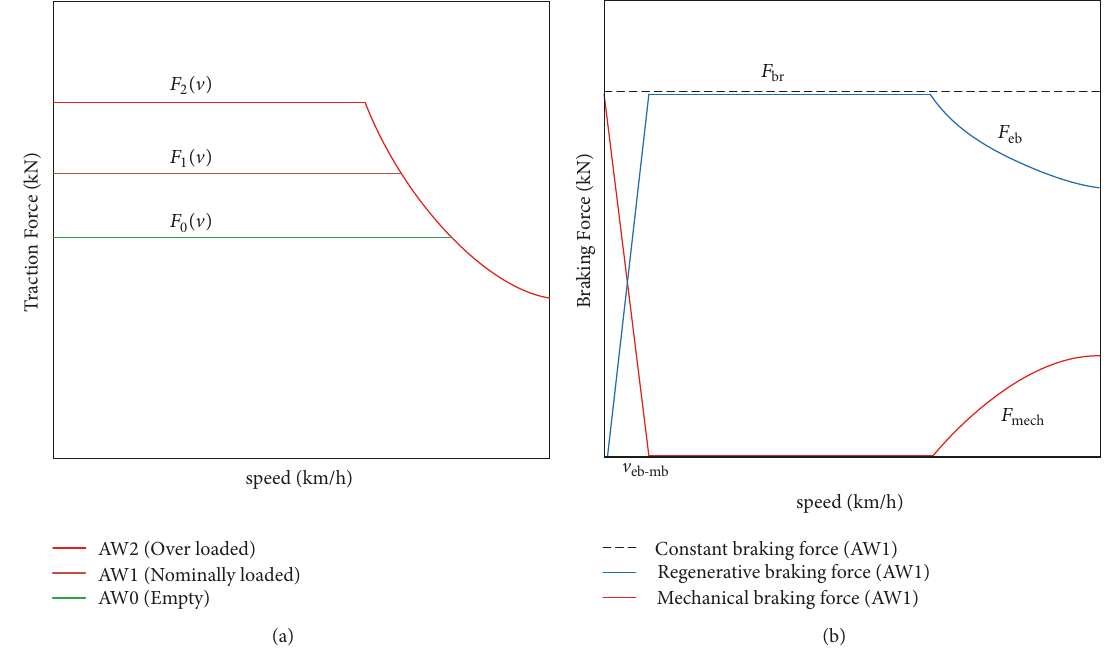
Figure 4: Maximum force against train speed. (a) Maximum traction force with different load factors. (b) Available braking forces in